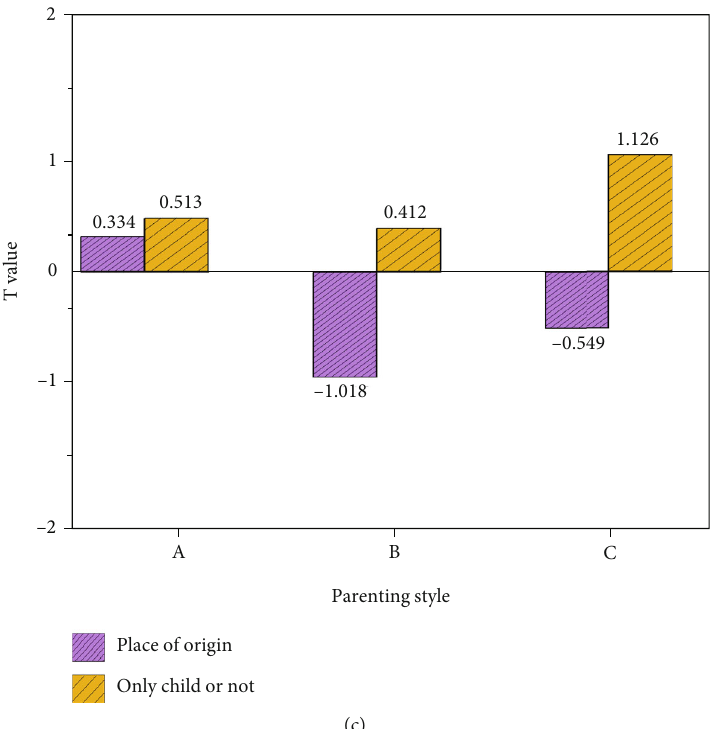
Figure 7: Di ff erence analysis of parenting style in the birthplace and whether or not it is an only child. (a) Di ff erence analysis of parenting style in birthplace; (b) di ff erence analysis of parenting style in whether or not the only child; (c) t -test of parenting style on birthplace and only